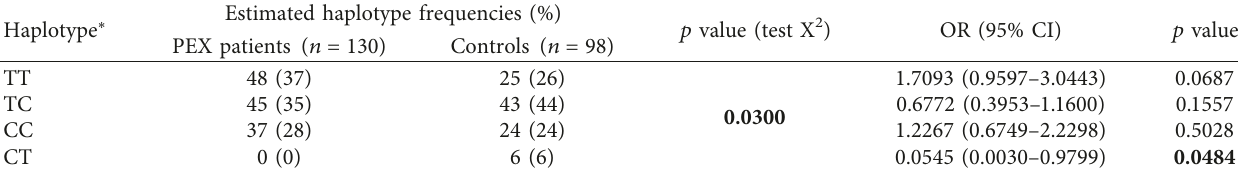
Table 5: Frequencies of CLU haplotypes in PEX patients and controls. Estimated haplotype frequencies Haplotype ∗